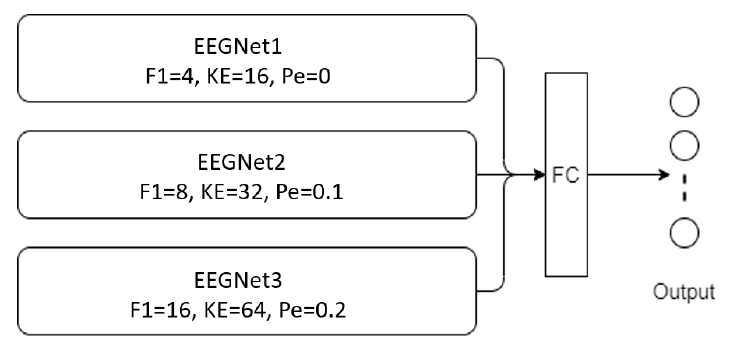
Figure 5. Architectural of MBEEGNet model (F1 = number of filters in temporal convolution, KE = kernel size in temporal convolution, Pe = dropout probability).